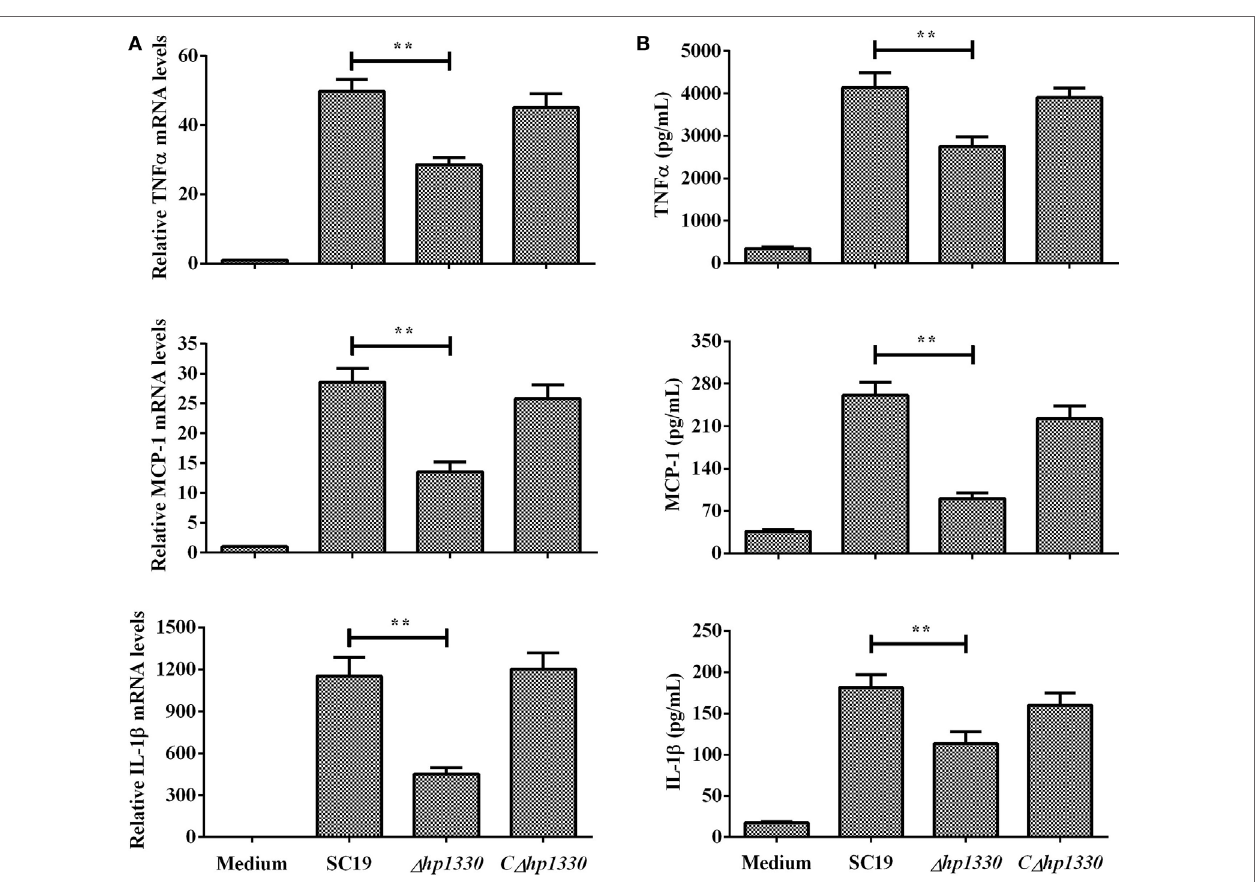
FigUre 5 | Induction of cytokine mRNA and protein expression in RAW 264.7 macrophages by SS2 strains. RAW 264.7 macrophages were incubated with the SC19, Δ hp1330 , and C Δ hp1330 strains for 6 h. (a) The mRNA levels of TNF- α , MCP-1, and IL-1 β were examined by qRT-PCR, (b) and the cytokine protein levels in the supernatants were examined by enzyme-linked immunosorbent assay. The bars represent the SEMs, based on three independent experiments. ** P <